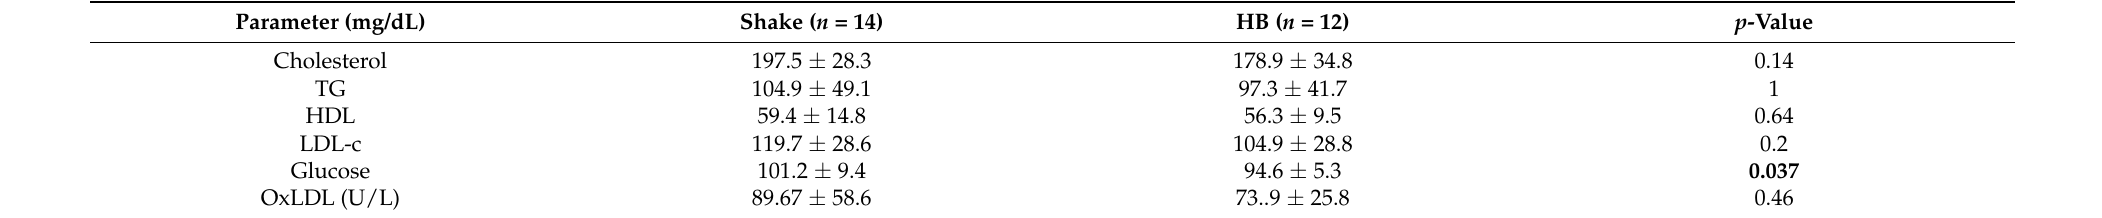
Table 3. Fasting lipid and glucose levels for Shake vs. Habitual Breakfast at Month